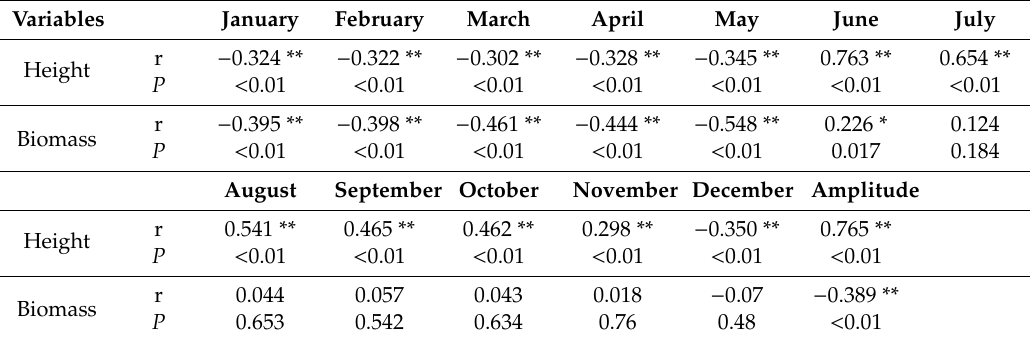
Figure 3. Upper and lower tolerance limits of water depth distribution for Typha angustifolia in each month across all lakes in which it was found. ( A ) Lakes with reservoir-like fluctuations; ( B ) Lakes with intermittent fluctuations and quasi-natural fluctuations. Table 1. Spearman rank correlations (r) between mean submergence depth in each month and the autumn height, and the autumn biomass of Typha angustifolia . Variables January February